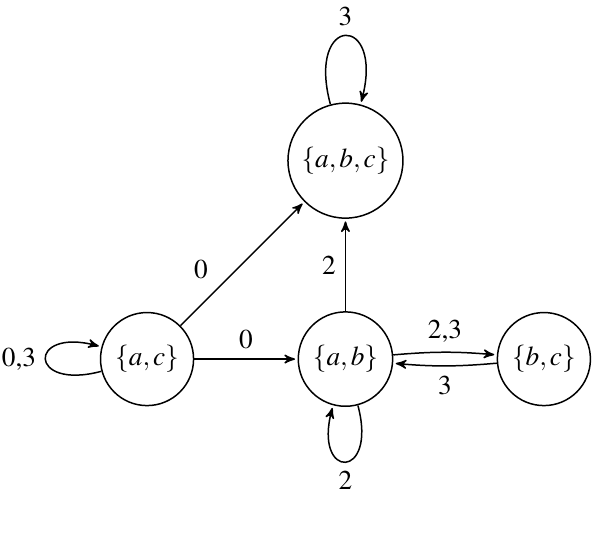
Figure 1: The graph for Example